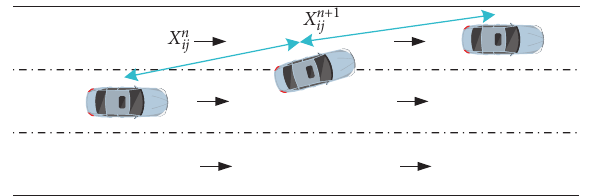
Figure 2: Vehicle instantaneous displacement.